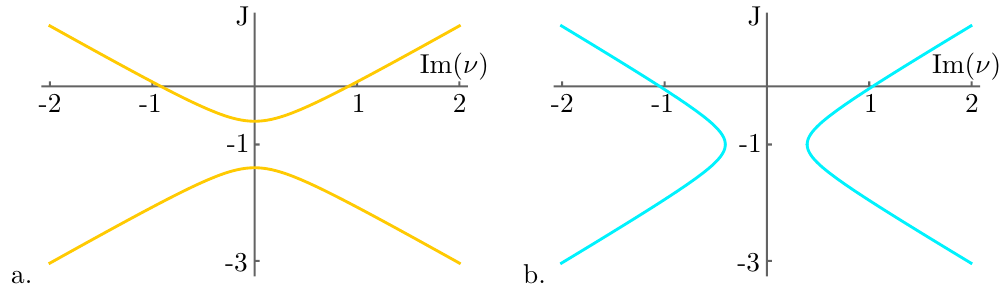
Figure 15 . Regge trajectories for the one-magnon four-point function. The J even and J odd tra- jectories are in the left and right panels, respectively. Note that the gap between the curves has length of order ξ 2